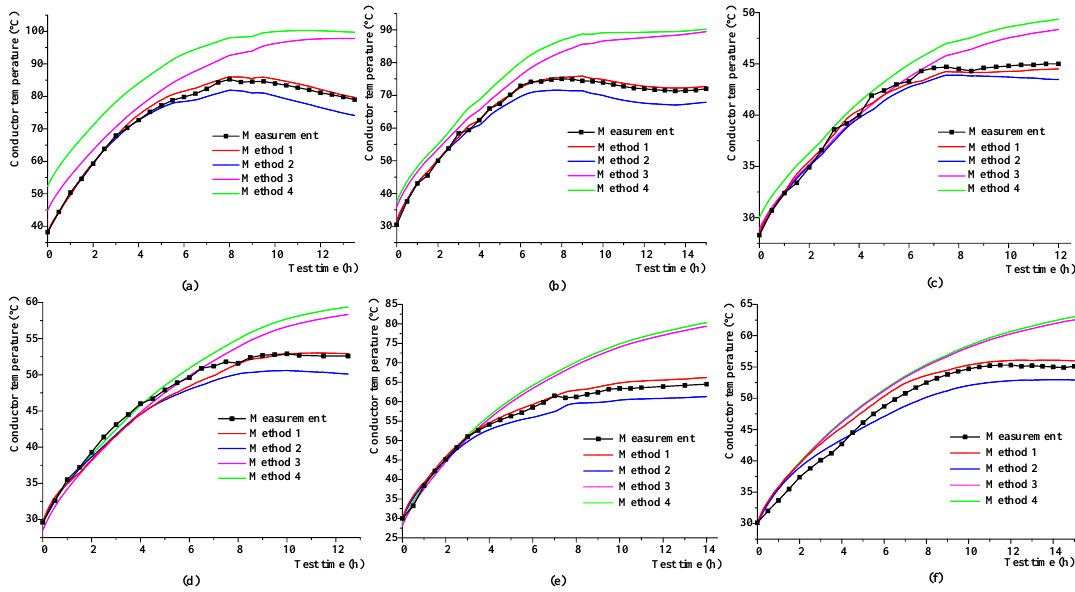
Figure 8. Calculated conductor temperatures based on different radial-positions and the measured conductor temperatures: ( a )–( f ) represent Cases 1–6.